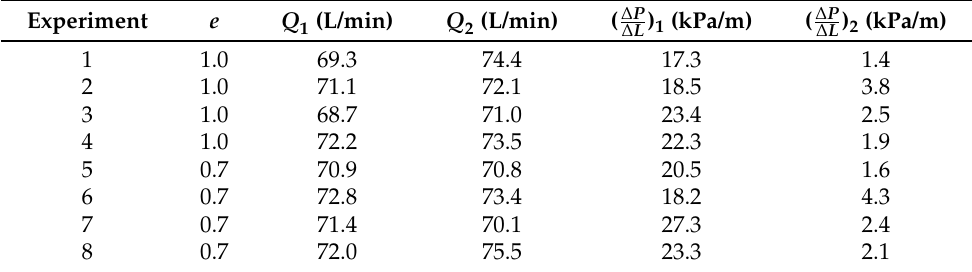
Table 3. Flow rates (L/min) and pressure drops (kPa/m) associated with each experiment.